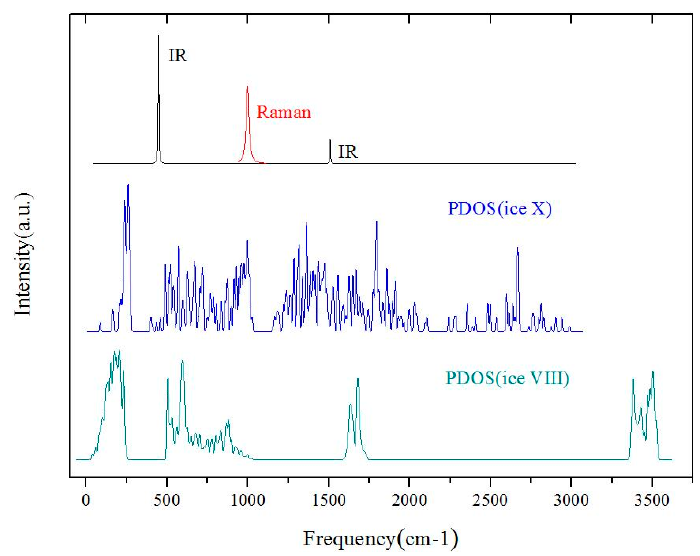
Figure 2. Three simulated spectra of ice X. IR, Raman, and the phonon density of states (PDOS) are colored in black, red, and blue, respectively. The PDOS curve of ice VIII is shown at the bottom for comparison.